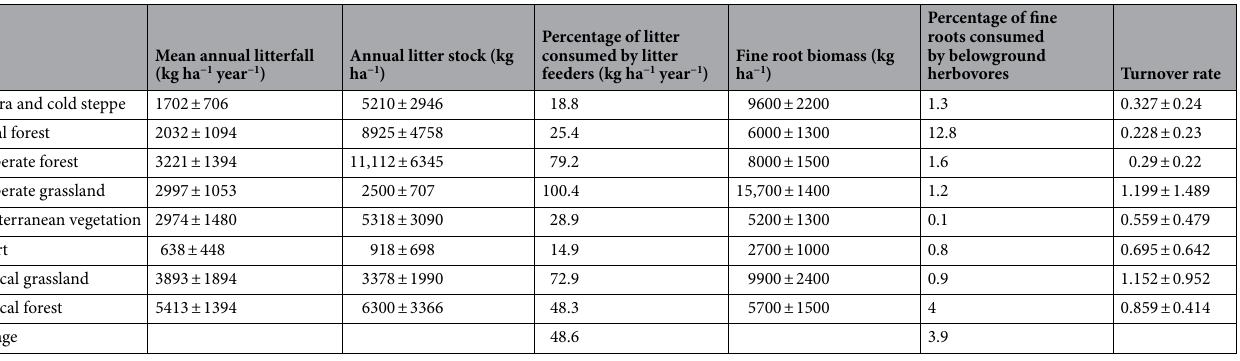
Table 2. Mean annual litterfall, percentage of litter consumed by soil fauna, biomass of fine roots, percentage of fine roots consumed by belowground herbivores, turnover rate and turnover time as affected by biome. Values refer to mean ± SE. Mean annual litterfall refers to leaf litter biomass produced during 1 year. Percentage of leaf litter consumed by litter feeders refers to litter consumed by litter feeders during 1 year. Fine root biomass refers to biomass of fine roots (≤ 2 mm in diameter) over 0–30 cm depth. Percentage of fine roots consumed by belowground herbivores over 1 year. Turnover rate refers the ratio of mean annual litterfall and mean litter stock. References for this table are included in Table